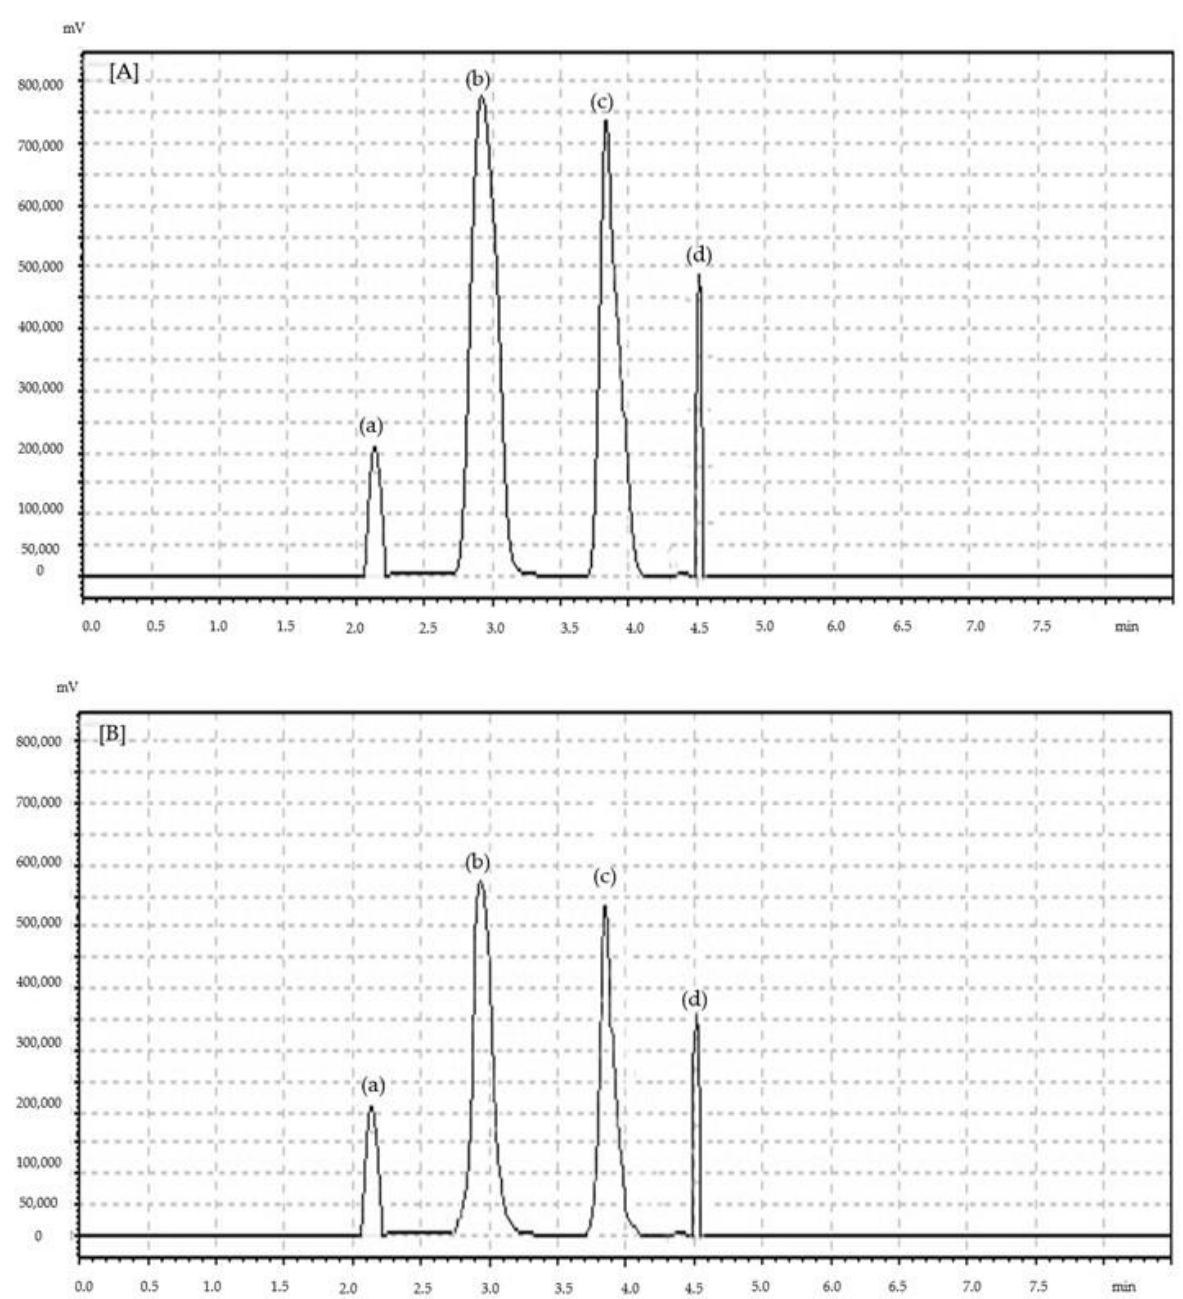
Figure 3. Chromatograms showing retention times anthocyanins in organic ( A ) and conventional ( B ) blackcurrant; ( a ) cyanidin-3-O-rutinoside, ( b ) delphinidin-3-O-rutinoside, ( c ) delphinidin-3-O-glucoside, ( d ) cya- nidin-3-O-glucoside.